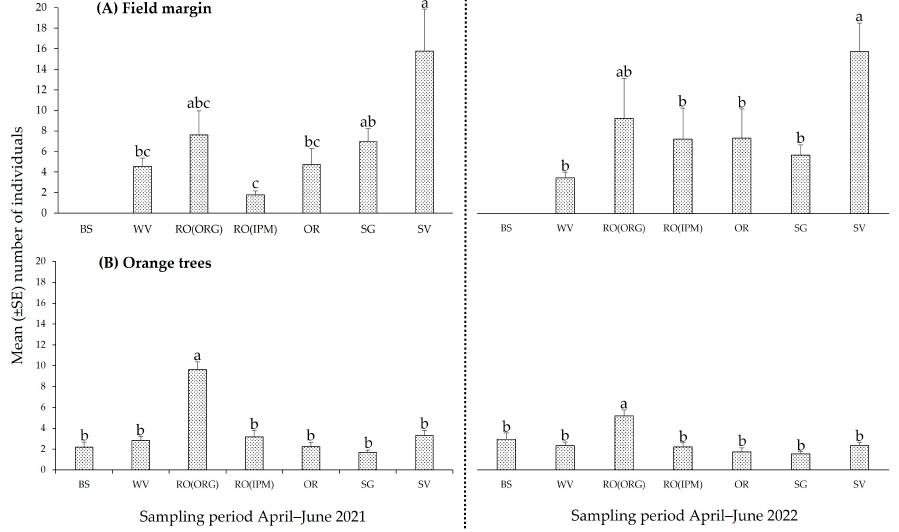
Figure 5. Total abundance (mean ± SE) of Hymenoptera parasitoids ( A ) in field margins and ( B ) on orange trees in orchards with di ff erent fi eld margin management: BS—bare soil; WV—weed vege- tation; RO(ORG)—rosemary hedgerow (organic orchard); RO(IPM)—rosemary hedgerow (IPM or- chard); OR—oregano hedgerow; SG—sage hedgerow; SV—savory hedgerow. Identical le tt ers above the error bar indicate no statistically signi fi cant di ff erences among orchards. Looking at their temporal abundance fl uctuation, parasitoid wasps on SV reached peak levels from late May to early June 2021 and similarly a tt ained their highest number in June 2022. On RO(ORG), a population peak was observed in early May 2021, while population peaks were recorded in both RO(ORG) and (IPM) orchards from late May to June 2022. The population pa tt ern of parasitoid wasps on OR was similar to that of RO hedgerows in 2022 (Figure 6A, Supplementary Tables S5 and S7). Parasitic wasps on or- ange trees in the rosemary RO(ORG) orchard had signi fi cantly higher abundance levels compared to the other orchards on all sampling dates in both years. In the other orchards, population peaks were observed in OR, RO(IPM), and SV fi elds from late May to June in 2021, while peaks were recorded in BS and OR fi elds in late June in 2022 (Figure 6B, Sup- plementary Tables S6 and S8).